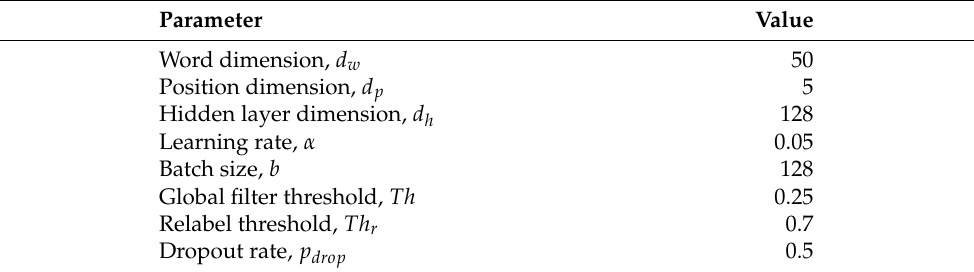
Table 2. Parameter settings.